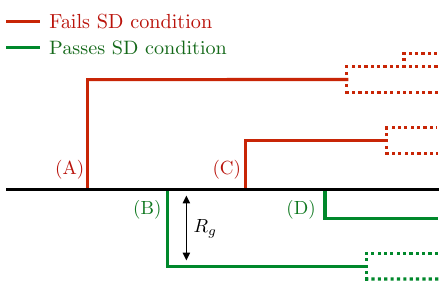
Figure 2 . Illustration of the (iterated) soft drop grooming algorithm. Branches along the most energetic branch (black) are tested against the soft drop condition, starting from the left. The reg- ular soft drop algorithm terminates when the first branch, here (B), passes the soft drop condition, which defines the soft drop groomed radius R g . Instead, iterated soft drop continues testing all branches at smaller angular scales, here (C), (D), where (C) is also groomed away in this example. The dotted lines correspond to branchings that are not tested against the soft drop condition in either